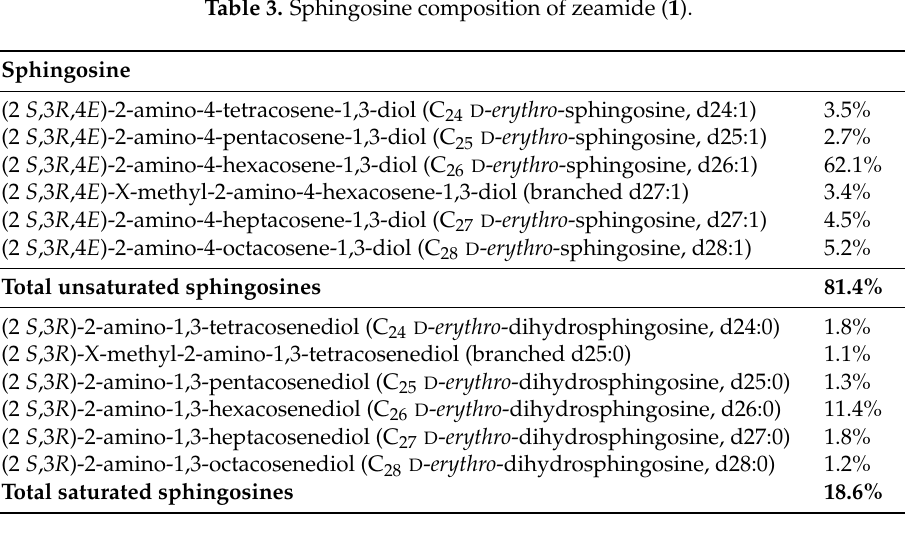
Table 3. Sphingosine composition of zeamide ( 1